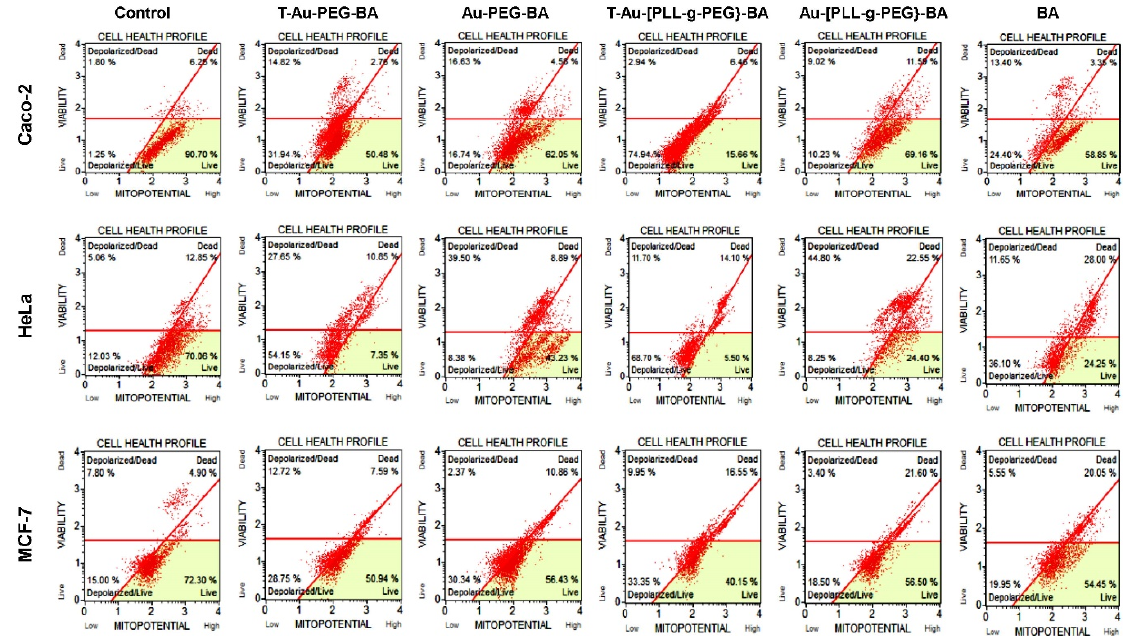
Figure 8. Cytographs of the effect of the targeted and untargeted nanocomplexes on the mitochondrial membrane potential in Caco-2, HeLa and MCF-7 cells. Au-PEG-BA; Au-[PLL-g-PEG]-BA = untargeted nanocomplexes, T-Au-PEG-BA; T-Au-[PLL-g-PEG]-BA = targeted nanocomplexes, and BA = free drug. Top left quadrat: cell death by mitochondrial depolarization; top right quadrat: non-mitochondria dependent cell death; lower left quadrat: mitochondrial depolarization in live cells; lower right quadrat: live cells.